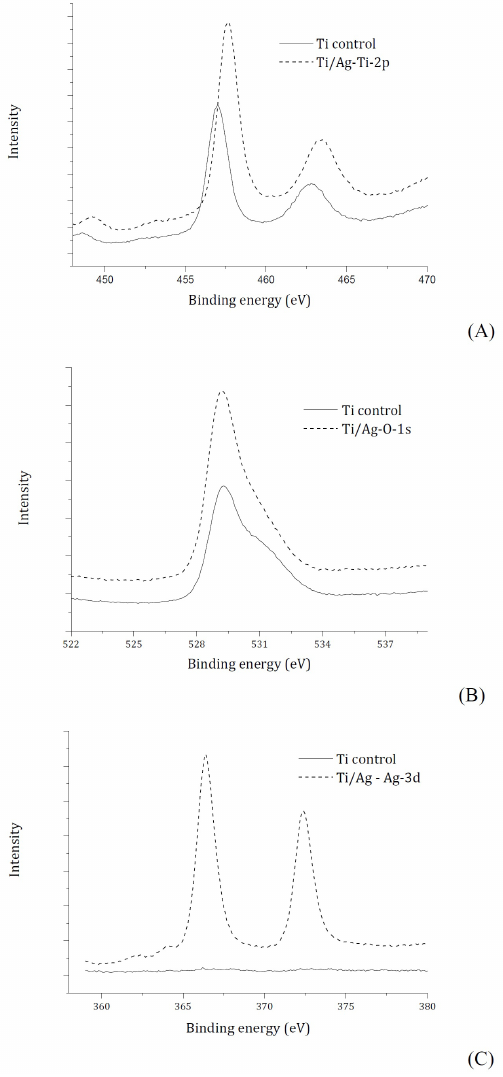
Figure 3. XPS spectra of major elements present on the surfaces of control samples and Ti/Ag plasma deposited samples (10 minutes), (A) Titanium, (B) Oxygen and (C) Silver. Table 1. Open circuit potential for Ti-control and Ti/Ag in artificial blood. Immersion time